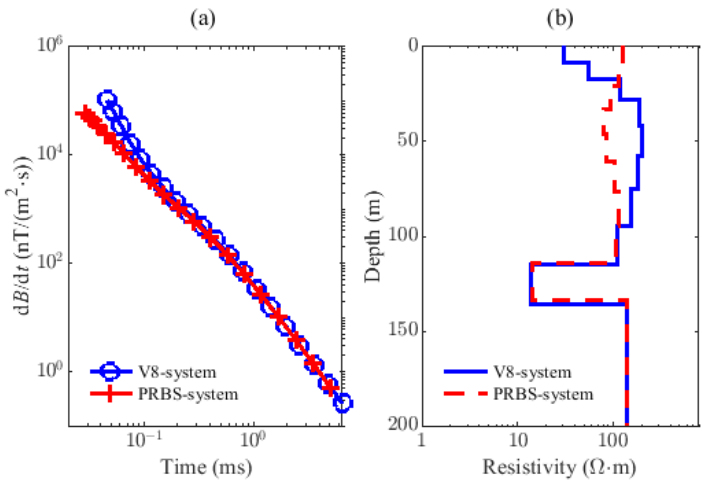
Figure 17. The data preprocessing results of PRBS system and V8 system. ( a ) The preprocessed observed data, ( b ) The inverted resistivity model of sounding shown in ( a ).